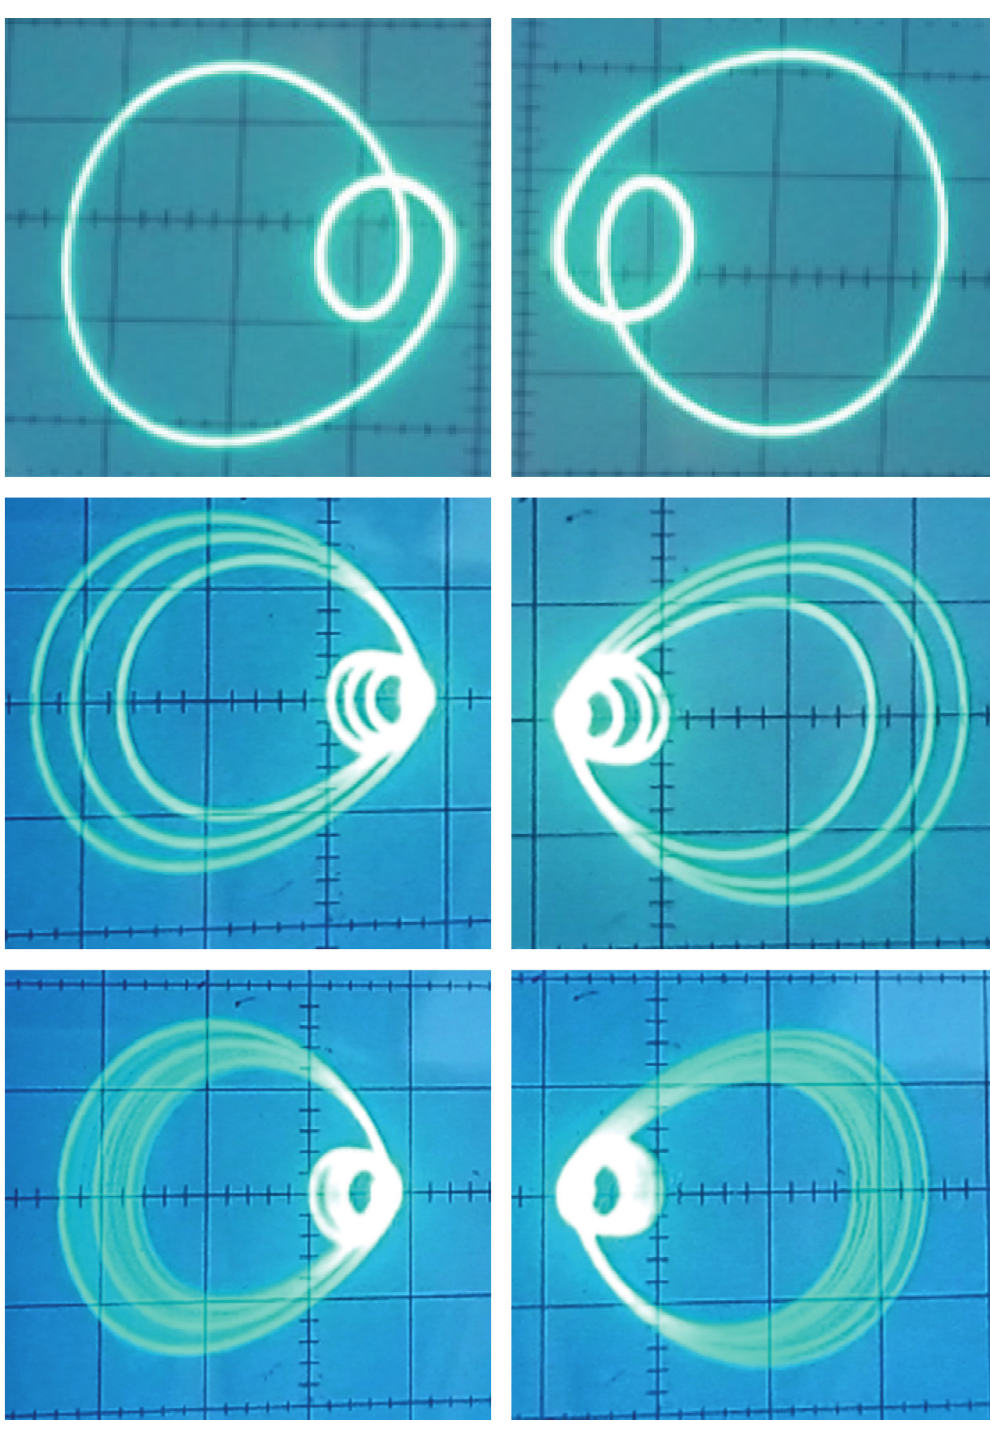
Figure 22: Coexistence of multiples attractors for R � 5 . 16 k Ω . Both periodic and chaotic attractors appear randomly in the experiment c when switching on and off the power supply. The scales are X � 5 V /div and Y � 2 V /div for all